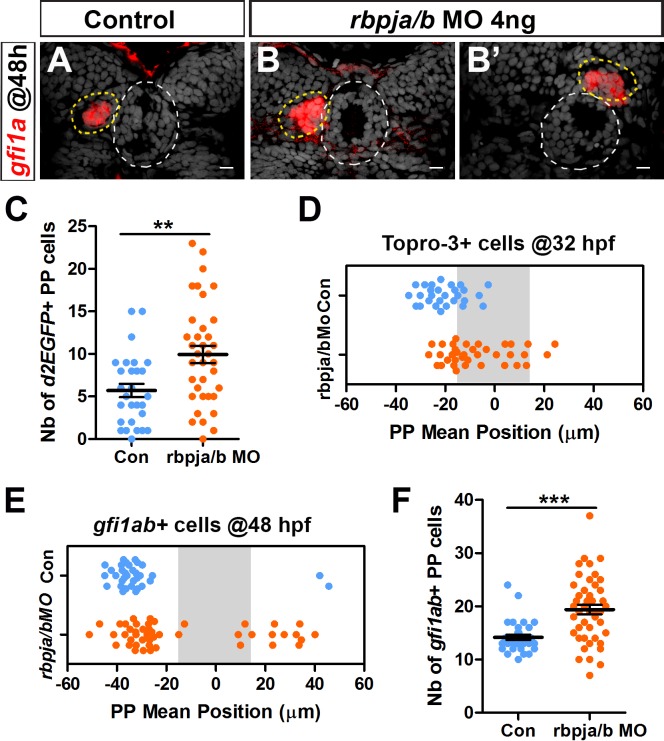
rbpja/b morphants phenocopy mindbomb mutants.(A–B’) Confocal sections showing the expression of gfi1ab (red) at 48 hpf in control embryos (A, n = 33) and in two representative embryos injected with 4 ng of rbpja/b morpholinos (MO) (B, B’); sections are merged with nuclear staining (gray) to highlight the epiphysis (white circle) and parapineal (yellow circle). Embryo view is dorsal, anterior is up; scale bar = 10 µm. (C–D) Dot plots showing the number of Tg(dusp6:d2EGFP) positive parapineal cells (C) and the mean position of parapineal cells highlighted by nuclei staining (Topro-3) (D) at 32 hpf in embryos injected with 4 ng rbpja/b MO (orange dots; n = 36) or in controls (blue dots; n = 28). (E–F) Dot plots showing the mean position (E) or the number (F) of gfi1ab expressing parapineal cells in non-injected controls (blue dots, n = 33) or in rbpja/b MO injected embryos (orange dots, n = 46) at 48 hpf. Both the migration (distance from the midline; p-value=0.0001 in Welch t-test on absolute value) and laterality (left orientation of migration; p-value=0.0002 on Wilcoxon test) are affected in rbpja/b morphants (E). The number of gfi1ab+ cells is also increased in rbpja/b morphants (F, *** p-value<0.0001; Welch t-test). Data are representative of three (A–B’, E–F) or two experiments (C–D).